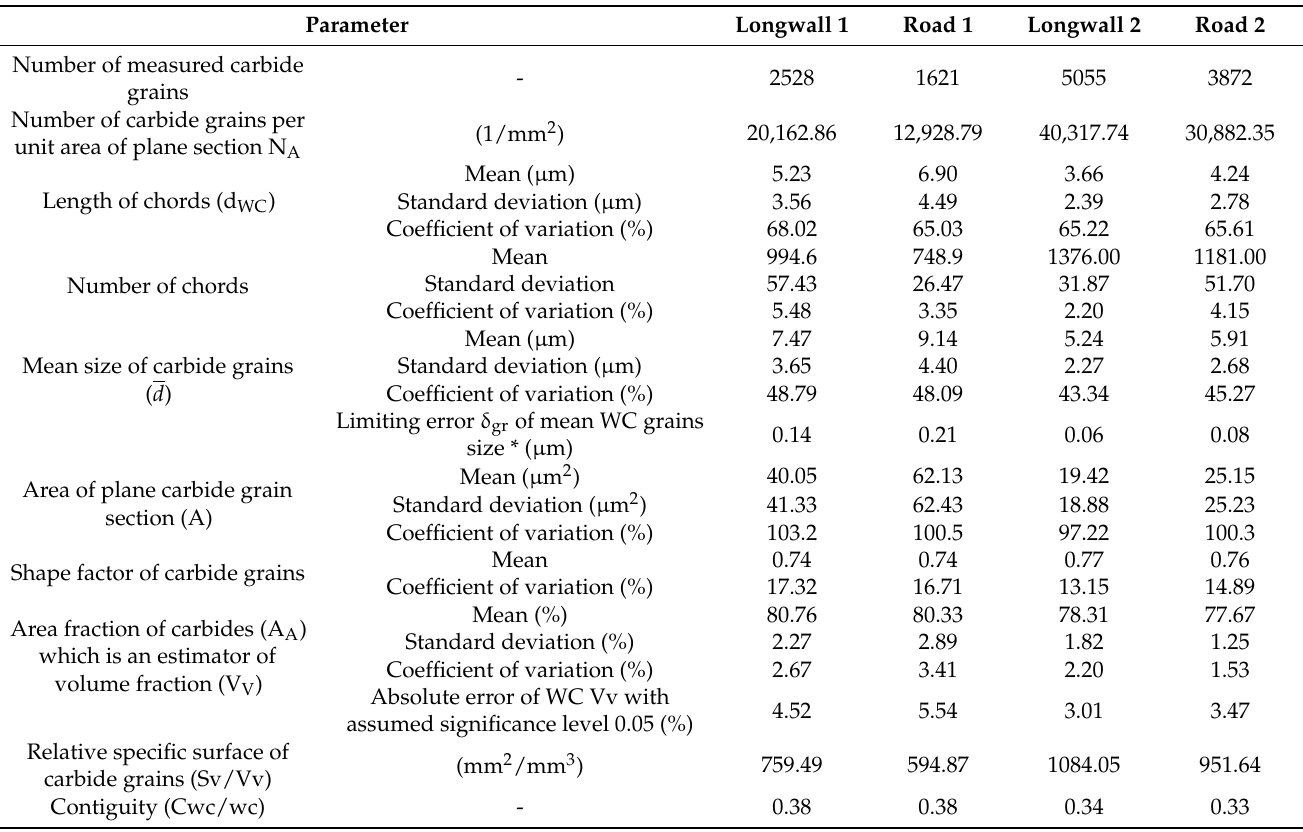
Table 2. Measurement results for the particular parameters of carbides in the examined